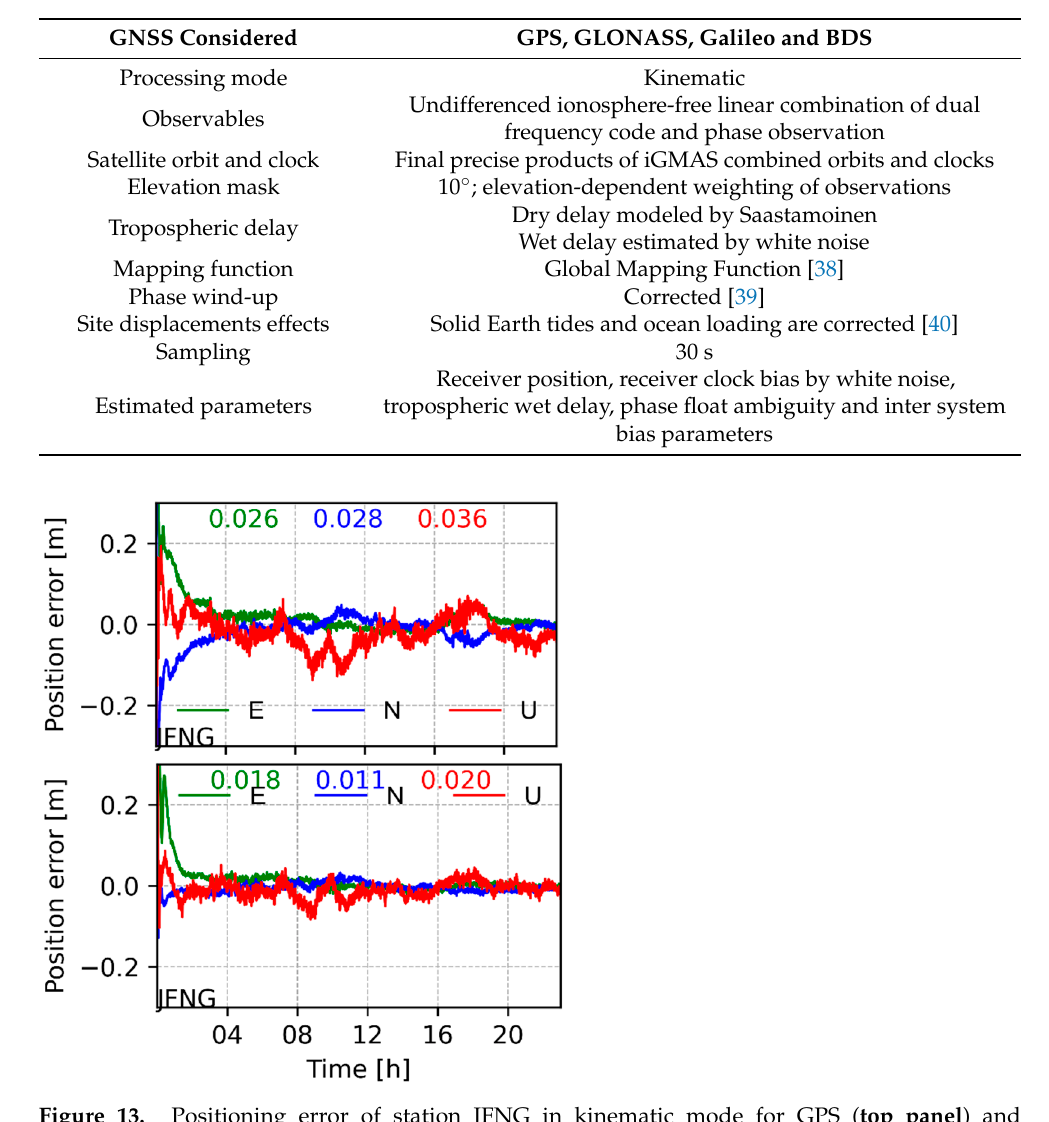
Table 2. Processing strategies applied for PPP tests.